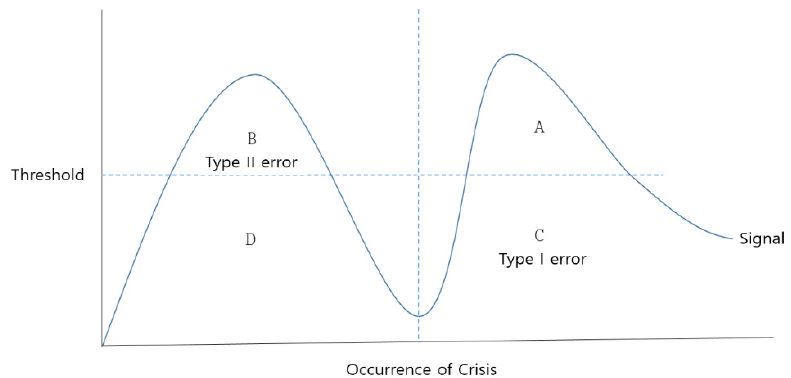
Figure 1. Number of cases for the crisis signal threshold.